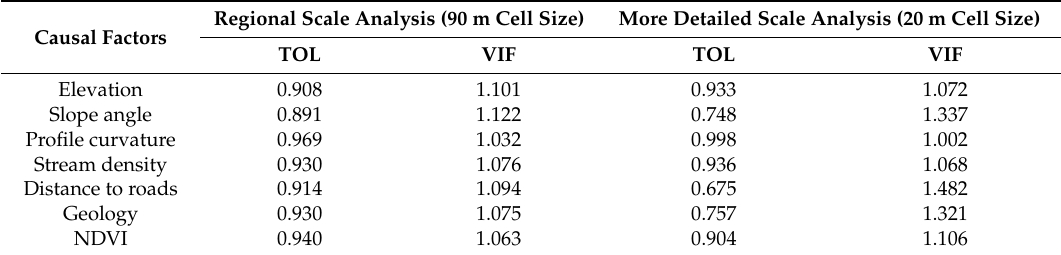
Table 2. Multicollinearity checking indexes for the causal